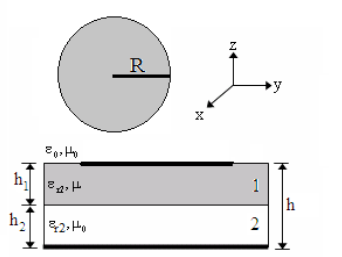
Figure 6: Circular patch antenna on two dielectric layers.